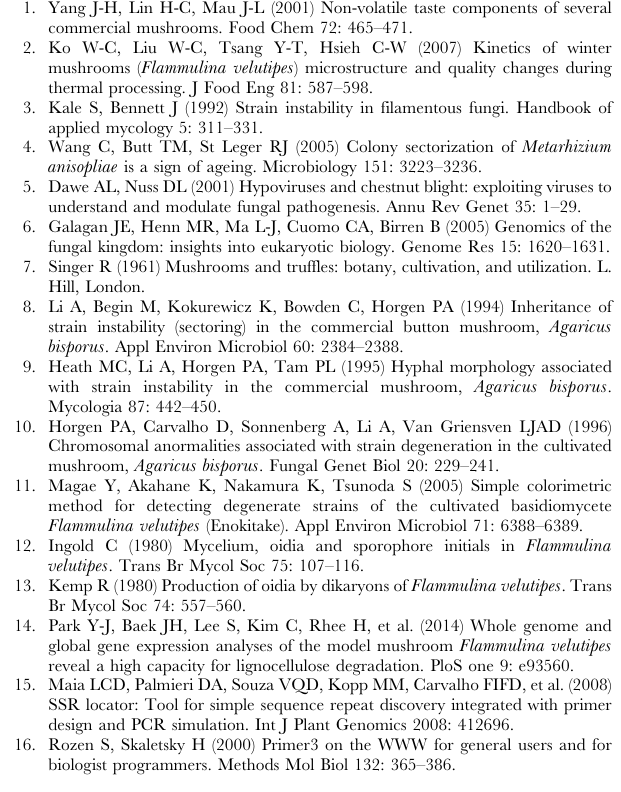
the W1 and D4 sequences indicate high similarity (99%), and the gray boxes indicate low similarity (30 to 70%). (TIF) Table S1 List of primers used in this